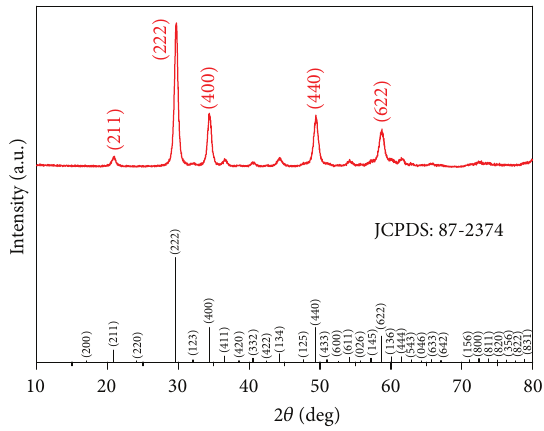
Figure 1: XRD pattern of Yb 2 O 3 :1% Eu 3+ nanocrystals (top) and standard diffraction of cubic phase Yb 2 O 3 (JCPDS: 87-2374, bottom for